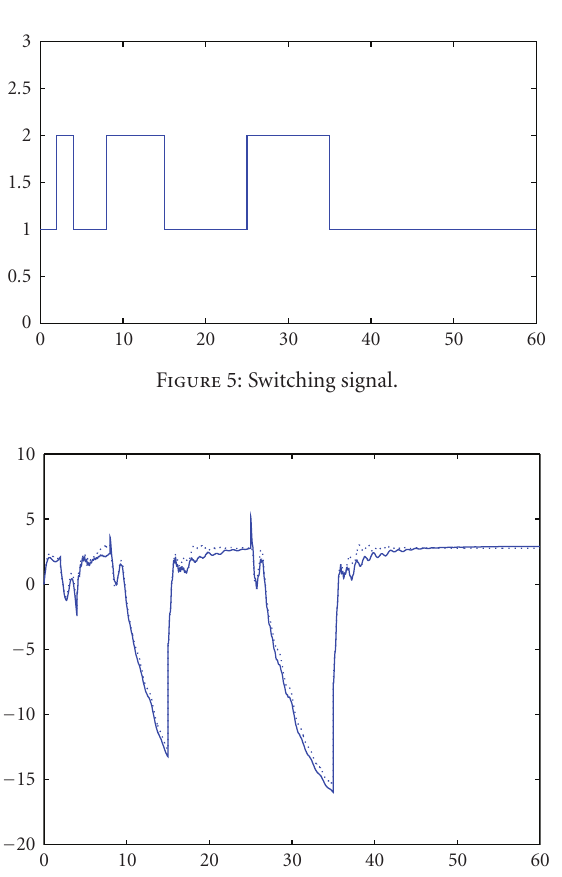
Figure 6: Step response of original switched linear system (solid line) and the reduced-order model which is of order 19 (dotted).